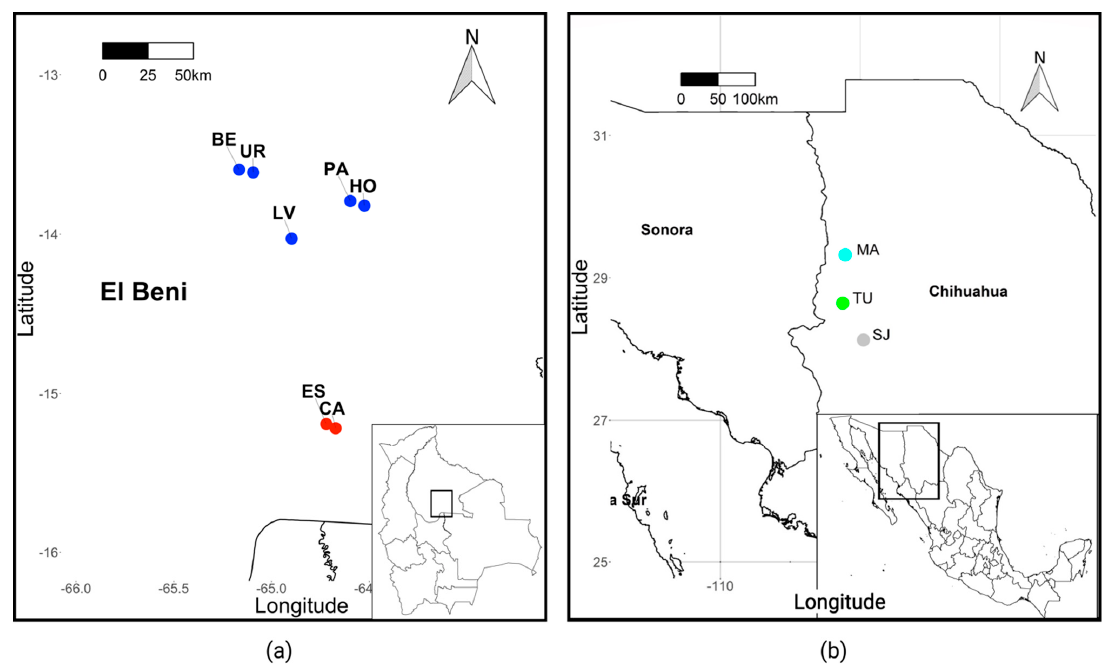
Figure 1. ( a ) Wild blue-throated macaw Bolivian sample sites. Northern subpopulation = blue; southern subpopulation = red. Sampling sites (individuals sampled): ES = Esperancita (25), BE = Bethel (9), HO = Holanda (8), LV = La Verde (6), PA = Palma Sola (5), CA = Cantina (5); UR = Urkupina (2). ( b ) Wild thick-billed parrot sampling sites. MA = Madera (37); TU = Tutuaca (8); SJ = San Juanito (1).